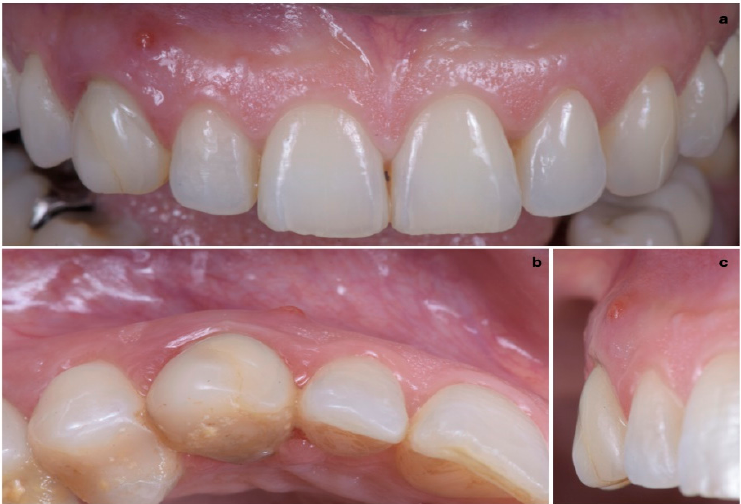
Figure 1. ( a – c ) Forty-year-old patient with endodontic fistula on maxillary right canine.